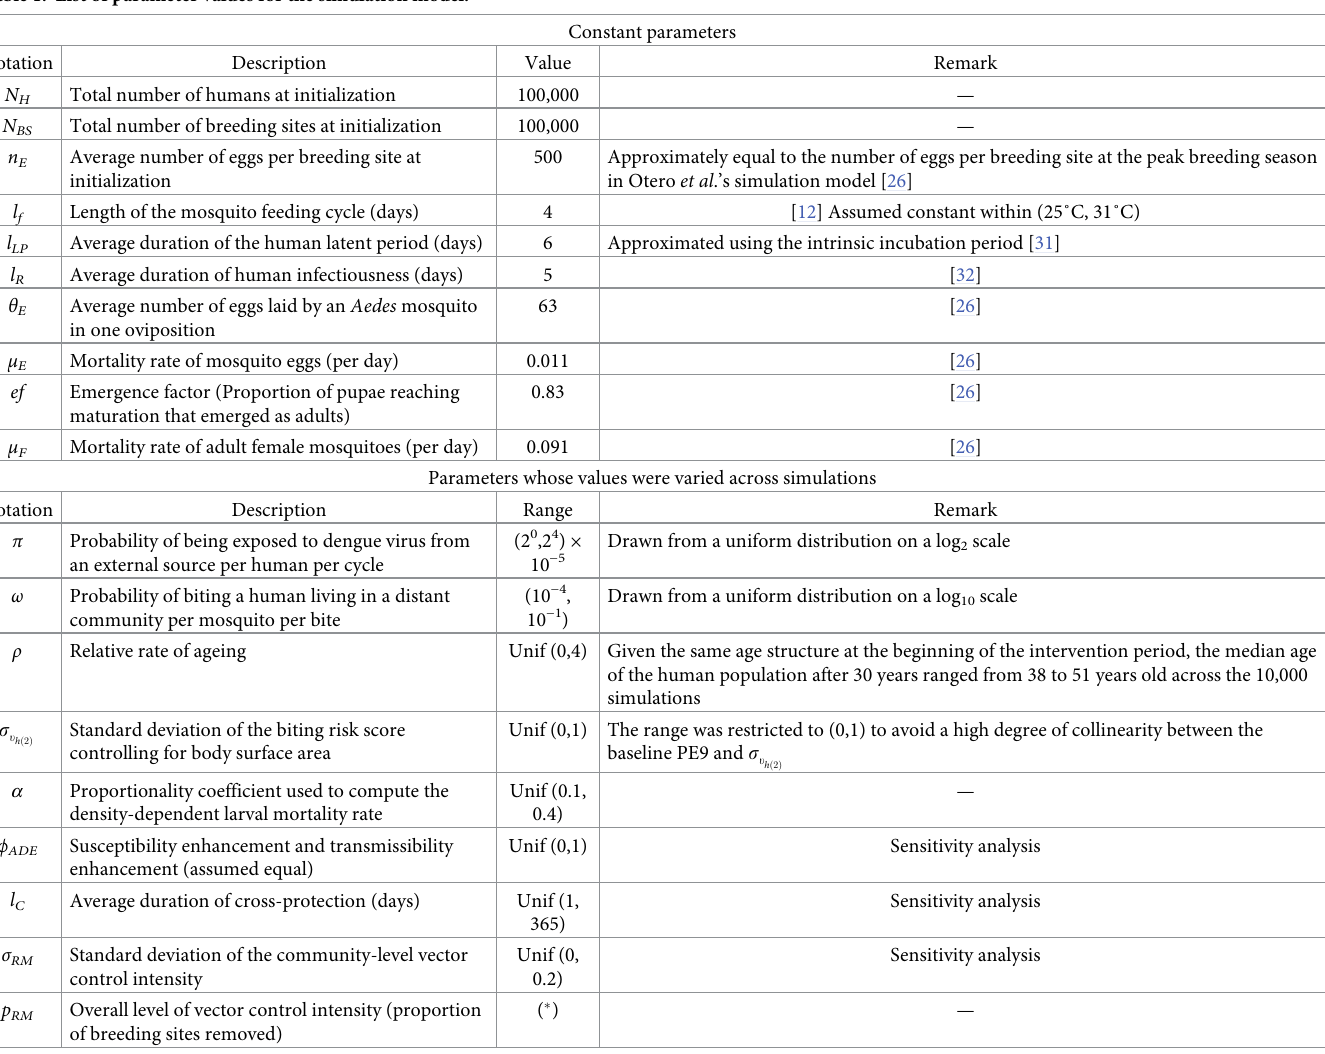
Table 1. List of parameter values for the simulation model.